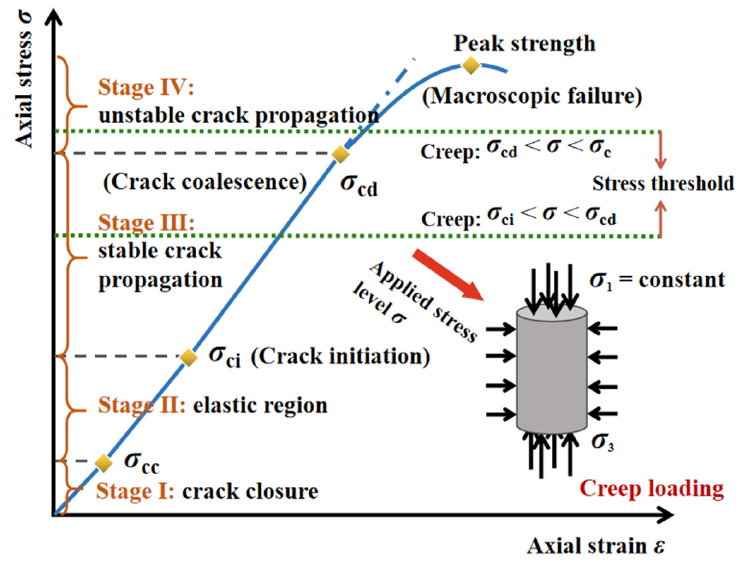
Figure 9. Schematic of crack development at stress thresholds.